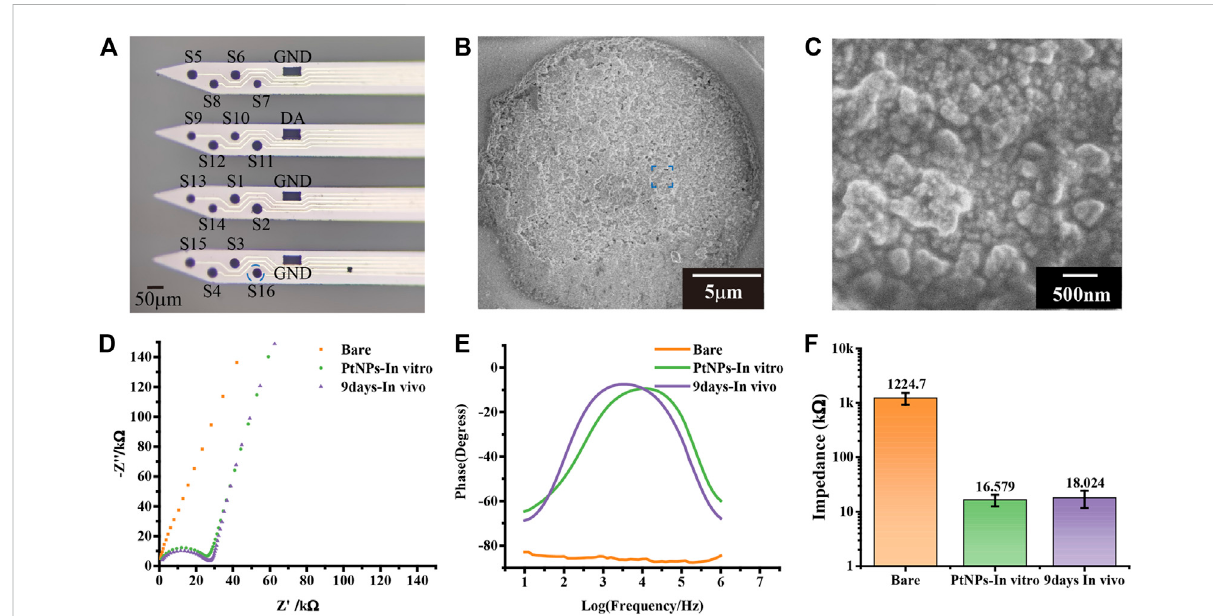
FIGURE 2 Performance characterization of the MEA. (A) The optical photos of modi fi ed nanomaterial MEA. (B,C) The scanning electron microscope image of modi fi ed nanomaterial MEA in electrode site and Pt nanoparticles. (D) Nyquist diagram of bare, PtNPs in vitro, and 9 days in vivo. (E)